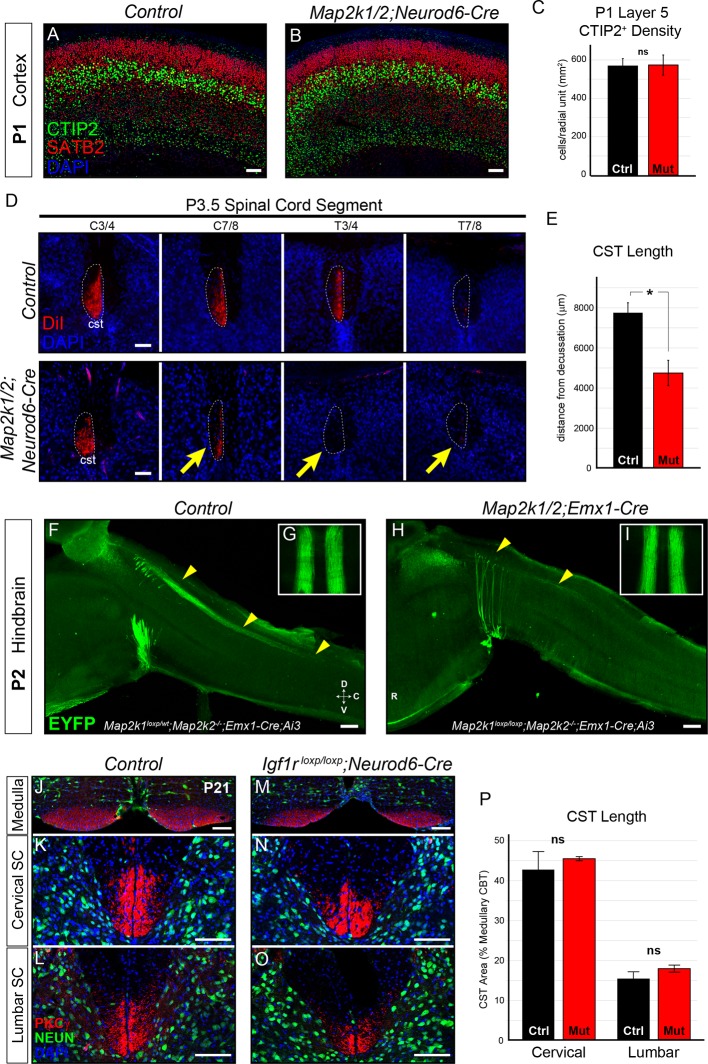
Layer 5 neuron corticospinal axon outgrowth requires ERK/MAPK signaling in vivo.(A–C) Expression of a well-known master transcription factor for layer 5 neurons, CTIP2, was intact in cortical layer 5 as shown in representative confocal images of newborn control (A) and Map2k1/2;Neurod6-Cre (B) sensorimotor cortices (scale bar=50 µm). Quantitation of the number of CTIP2-expressing nuclei in cortical layer 5 (C) did not reveal a significant difference in CTIP2+ neuron density between control and mutant neonates (n=3, mean ± SEM, p=0.89). (D–E) In vivo DiI injections into the sensorimotor cortex of P0.5 control and Map2k1/2;Neurod6-Cre neonates were performed and mice were collected three days after injection. The extent of anterograde DiI labeling was analyzed in coronal sections through the spinal cord (D). We observed a significant decrease in the extent of corticospinal (cst) elongation in mutant mice, especially in the lower cervical/thoracic spinal cord segments (yellow arrows in D) (n=3, scale bar=100 µm). Quantitation of CST length relative to the medullary decussation revealed a significant decrease in corticospinal axon growth in mutant spinal cords (E) (n=3, mean ± SEM, *p=0.02). (F–I) The initial stages of corticospinal elongation in the dorsal spinal cord can be visualized in sagittal sections of the caudal medulla and rostral spinal cord from P2 Emx1-Cre;Ai3 mice. Immunoenhancement of the Ai3 reporter with an EGFP antibody clearly shows that the caudal extension of corticospinal axons (yellow arrowheads) is profoundly reduced in P2 Map2k1loxp/loxp;Map2k2-/-;Emx1-Cre;Ai3 mutant mice (H) when compared to Map2k1loxp/wt;Map2k2-/-;Emx1-Cre;Ai3 controls (F) (n=3, scale bar=200 µm). Whole mount visualization of the CST coursing through the ventral medulla in control (G) and mutant (I) hindbrains did not reveal an overt difference in corticospinal growth (n=3). (J–P) Compared to control mice (J–L), Neurod6-Cre mediated deletion of Igf1r did not alter the relative area of PKCγ labeling in the cervical (K, N, P) or lumbar (L, O, P) CST compared to the medullary CBT (J, M) in mutant mice (M–O) at P21 (n=3, scale bar=50 µm).